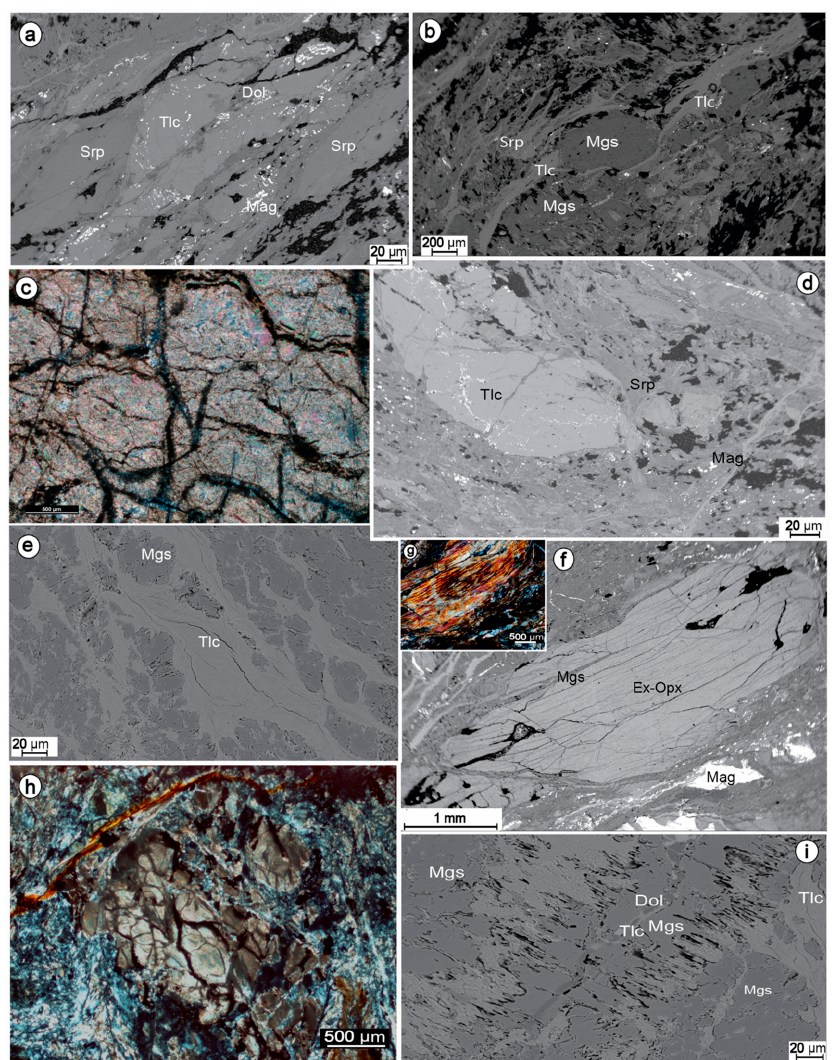
Figure 10. ( a ) sigmoids of serpentine and talc in the mylonitic serpentinite domain; tiny magnetite crystals are aligned along the main schistosity. Within the talc, small dolomite minerals are recognizable; ( b ) magnesite δ -type porphyroclast with strain shadows filled by talc; ( c ) chrysotileveinlets cross cutting talc crystal; ( d ) microstructures pointing to plastic deformation accommodated by a dissolution–precipitation mechanism in the presence of weak minerals as talc and serpentine; ( e ) Interconnected network of talc and magnesite; ( f ) bastite texture (lizardite + fine-grained carbonate) with lamellar extinction and striations disposed along the cleavage planes of the original orthopyroxene in SEM/BSE image; ( g ) the same pseudomorphic texture under optical microscope (crossed nicols); ( h ) deformed mesh boundaries picked out by magnetite and characterizing the substitution of olivine crystal with serpentine (lizardite) and talc (optical microscope, crossed nicols); ( i ) vein filled with magnesite and having serrated boundaries indicating a reaction processes producing talc. Along the central axis of the vein, dolomite and talc in small amounts indicate dissolution–precipitation reactions producing talc.